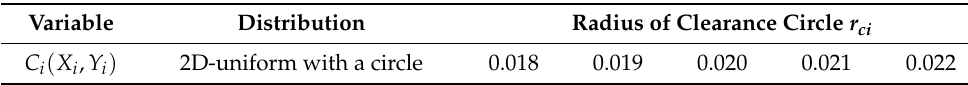
Figure 11. Schematic diagram of four-bar linkage. Table 1. Distributions of random variables.